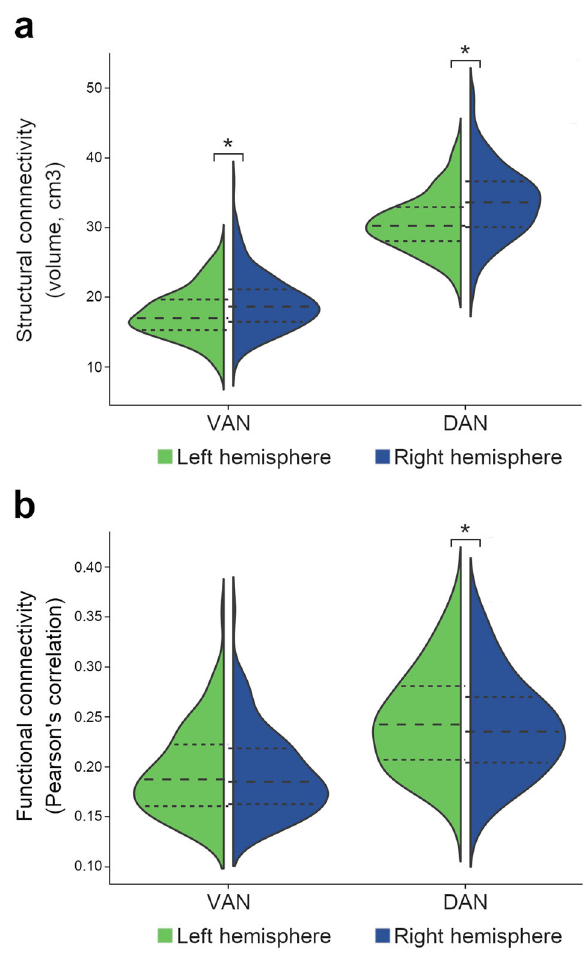
Fig. 4 VAN and DAN lateralization. Structural connectivity is expressed in volumes of the structural connection maps ( a ) and functional connectivity in average Pearson ’ s correlations ( b ) across hemispheric nodes. Dashed lines represent the median and the interquartile range; the minimum and maximum correspond to the violin limits. DAN dorsal attention network, VAN ventral attention network. Asterisk (*), signi fi cant differences between the right and the left hemispheres ( p < 0.05; paired analysis; structural connectivity, n = 177; functional connectivity, n =